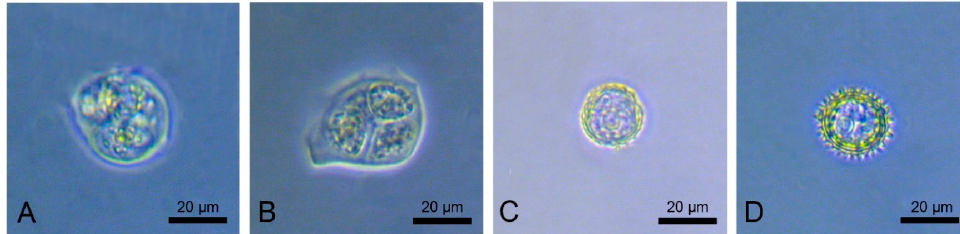
Figure 2. Stages of sunflower microspore development: ( A ) between meiotic dyad and tetrad; ( B ) tetrad of microspores; ( C ) early uninucleate microspore; and ( D ) late uninucleate microspore. Photographs were taken by authors of this review.